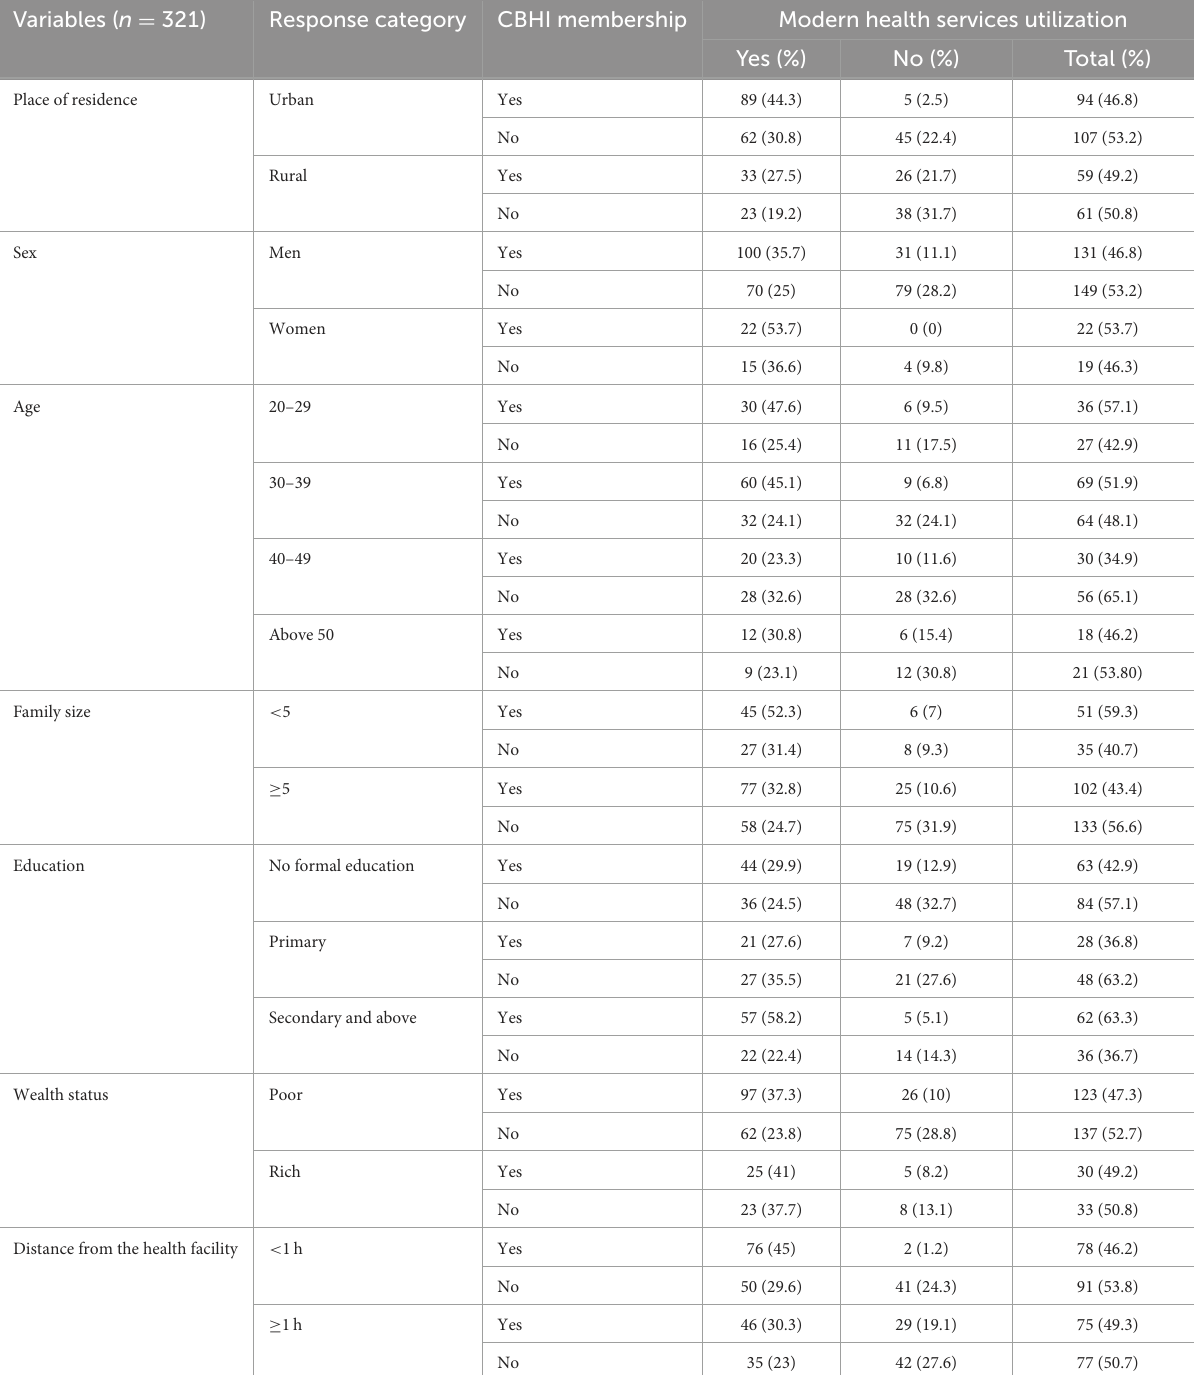
TABLE 1 Sociodemographic and economic characteristics among households in the Gida Ayana district, Oromia Regional State, Ethiopia, 2022. Variables ( n =